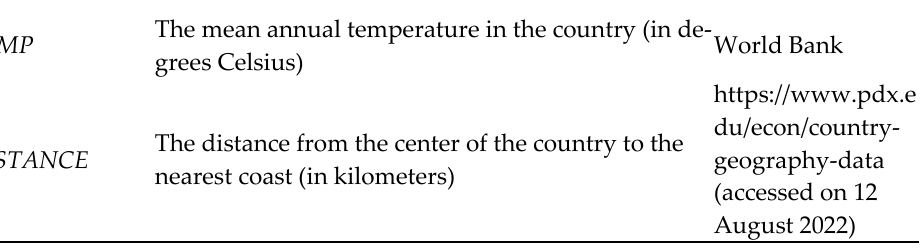
Figure 1. Definitions and Sources of Variables. Note: Hofstede et al. (2010); La Porta et al. (1998).